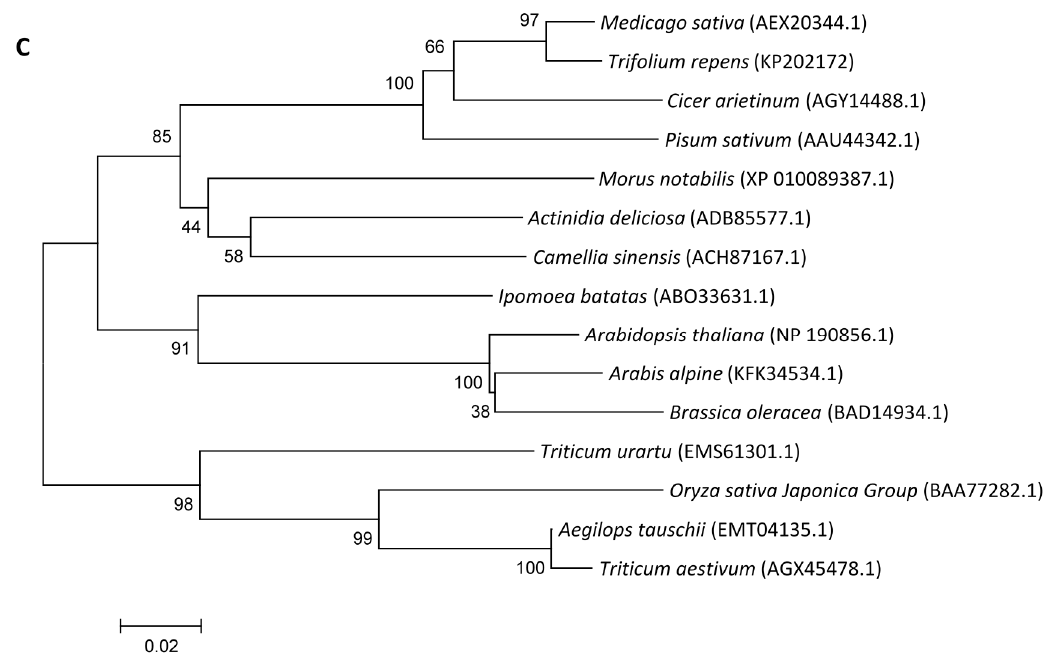
Figure 1. Phylogenetic tree analysis of FeSOD ( A ); DHAR ( B ) and MDHAR ( C ) from plants, the related information from NCBI.